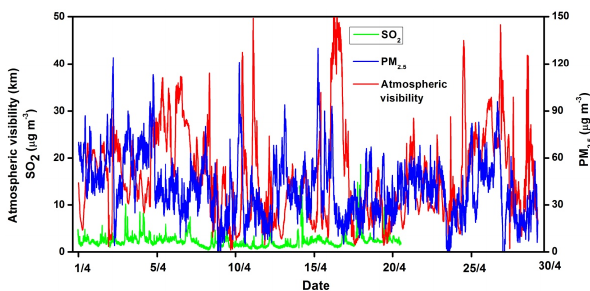
Figure 2. Series of 5min mean SO 2 and PM 2 . 5 concentrations and atmospheric visibility over the entire